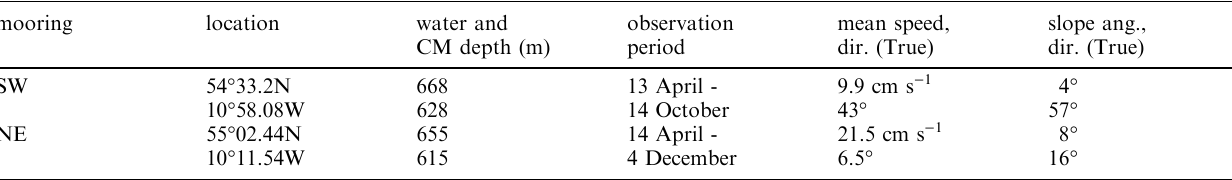
Table 1. Mooring locations, water/instrument depths and mean values for current meters deployed northwest of Ireland, 1994 mooring location water and